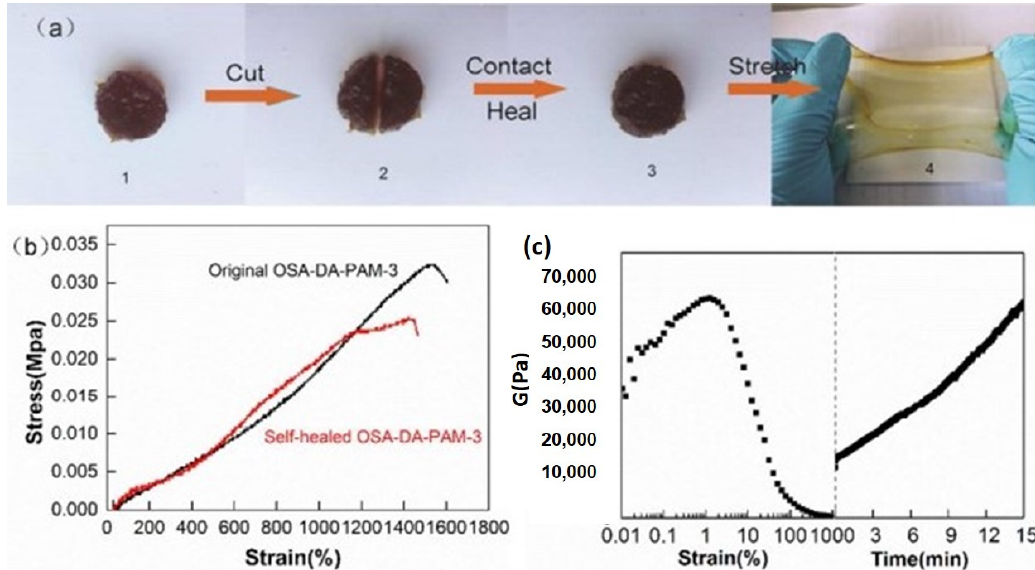
Figure 7. Methods for confirming self-healingability ( a ) 1, 2, 3— c ut- h eal ability, 4— s tretchability ( b ) s tress-strain curves of the fabricated hydrogel compared with the self-healed hydrogel ( c ) r heological property of hydrogel. ( Reproduced with permission from Ref. [100]. Copyright 2018, American Chemical Society).